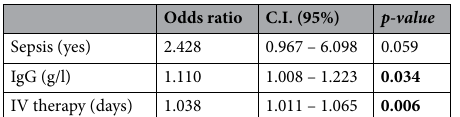
Table 4. Logistic regression (dependent variable: sequelae). Significant values are in bold